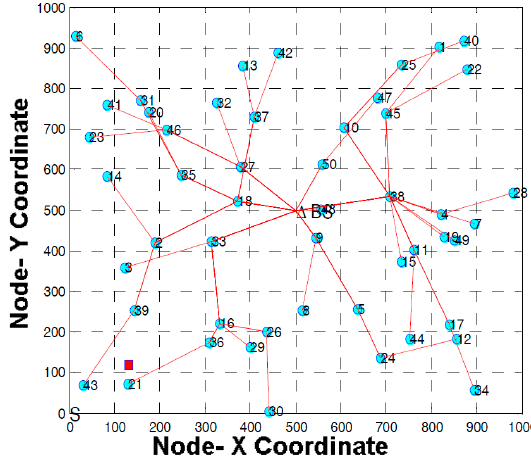
Figure 6. Shortest path measurement.